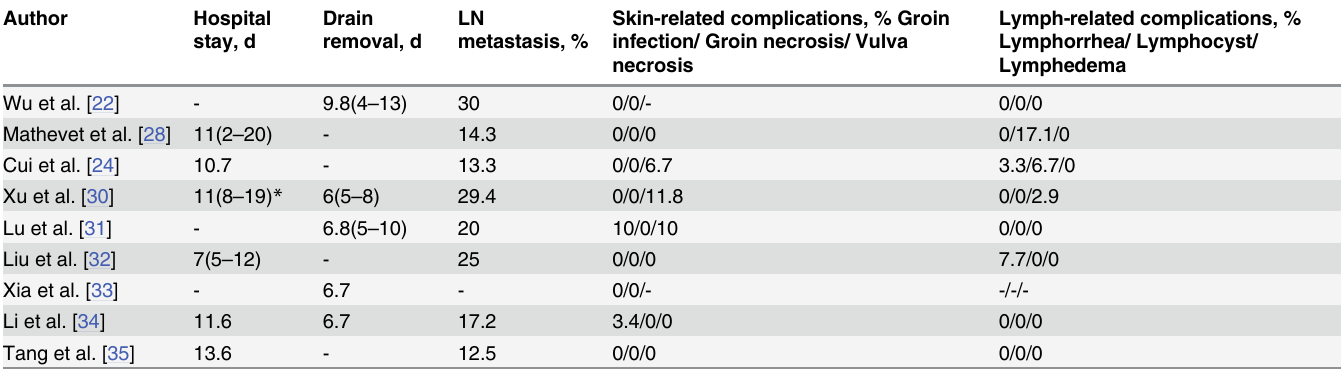
Table 3. General Conditions and Short-Term Complications in the Postoperative